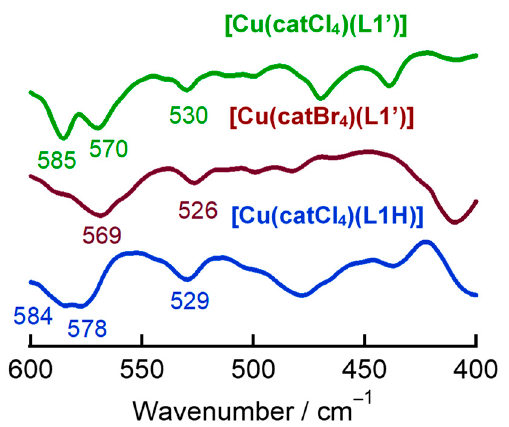
Figure 4. Far-IR spectra of [Cu(catCl 4 )(L1 ′ )] ( top ), [Cu(catBr 4 )(L1 ′ )] ( middle ), and [Cu(catCl 4 )(L1H)] ( bottom ) measured by CsI pellets.